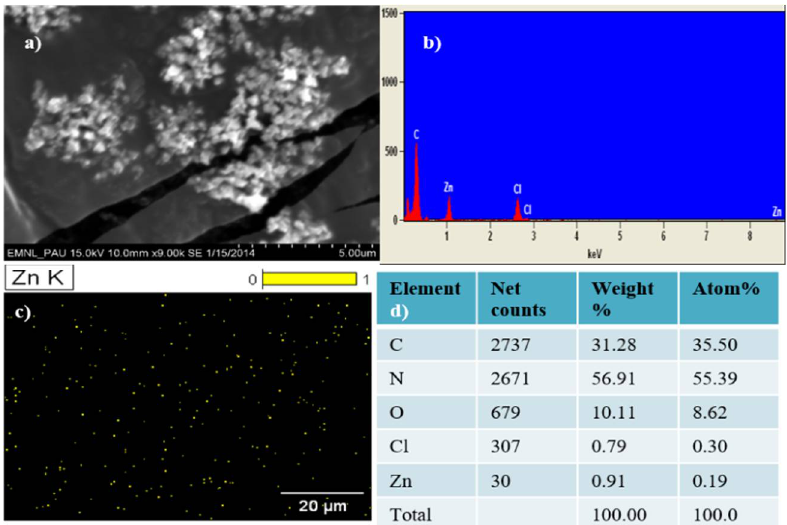
Figure 2. Scanning electron micrograph of ZnONPs depicting ( a ) the smooth-surfaced aggregates, ( b ) SEM-EDS spectra of the prepared ZnONPs showing characteristic peaks for the Zn element, ( c ) X-ray map of ZnONPs showing the signals for the uniformly distributed Zn element, ( d ) quantitative table exhibiting the occurrence of % atom and % weight Zn element.